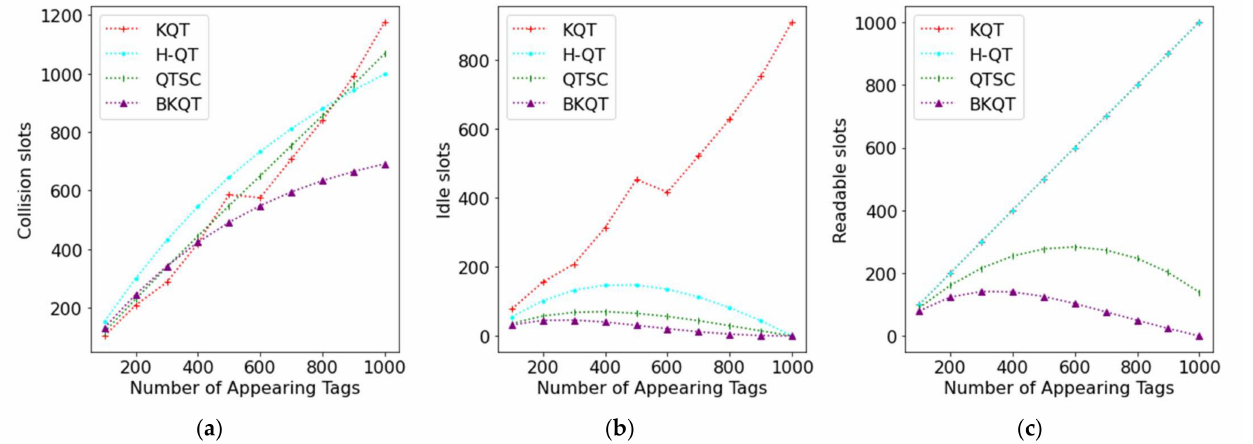
Figure 3. Collision, idle, and readable slots subject to the number of appearing tags (note that the curves of KQT and H-QT overlap in ( c )). ( a ) Collision slots, ( b ) Idle slots, ( c ) Readable